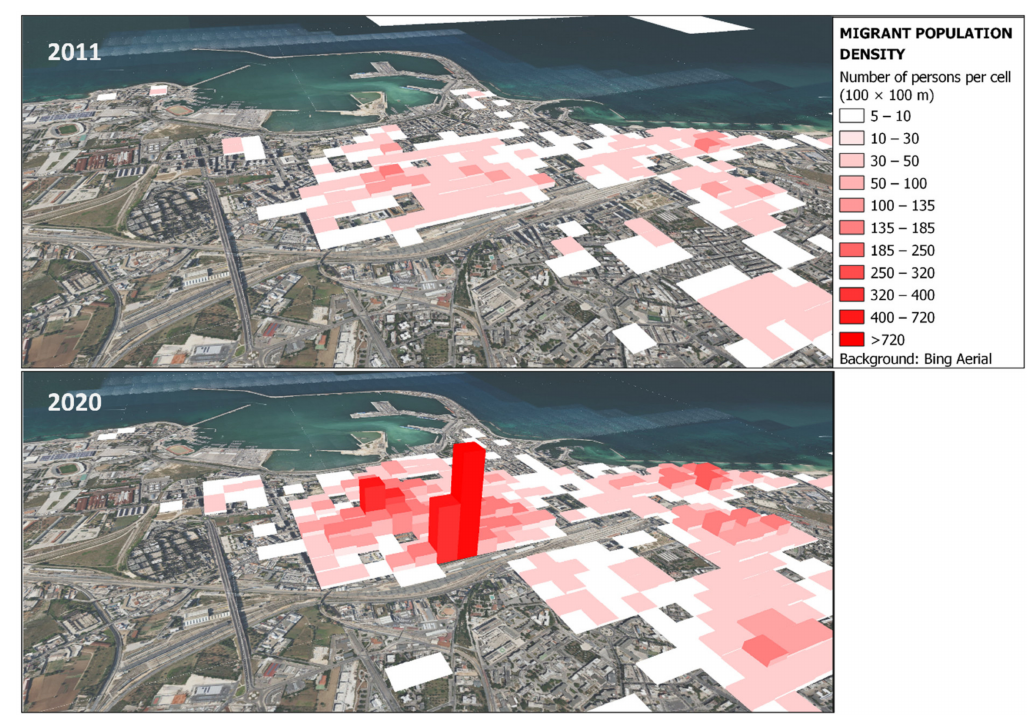
Figure 4. The numbers of regular migrant residents in 2011 and 2020 in the Bari central area: three-dimensional elaboration of migrant-population density calculated in [29]. The height of each parallelepiped is proportional to the number of resident migrants, whereas the color changes accord- ing to the classes shown in the legend.